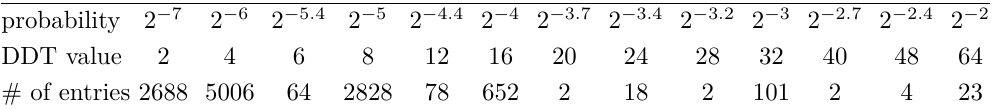
Table 8: Distribution of non-trivial probabilities in DDT of SKINNY-128 ’s S-box. probability 2 −